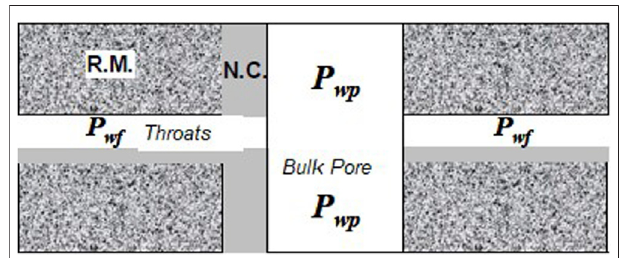
FIGURE 1 | Conduction model of complex pore structure (Shang et al.,